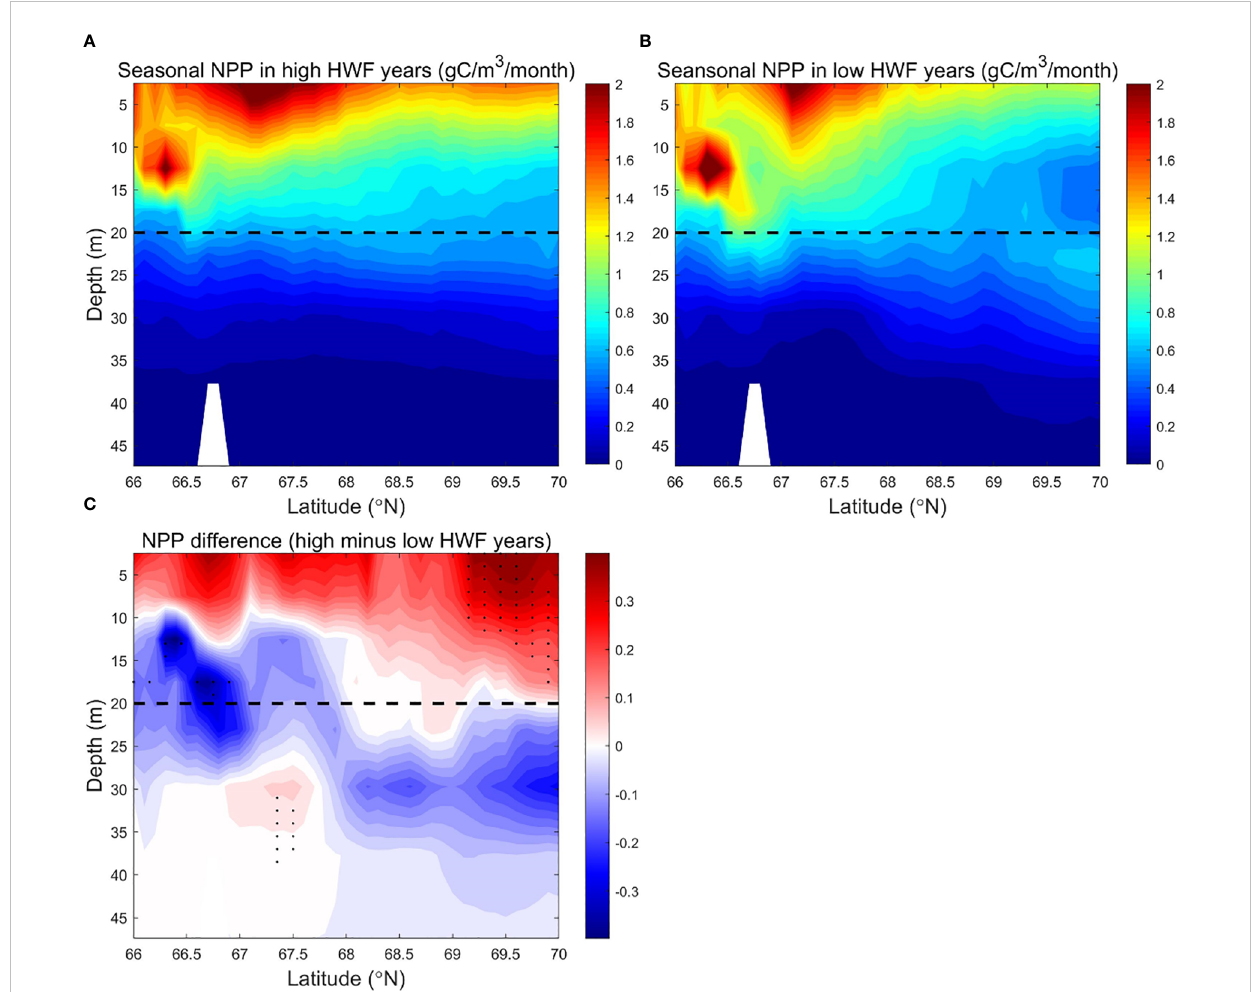
FIGURE 7 Modeled seasonally (June to September) averaged NPP (g C/m3/month) in the SC in the (A) high (1990, 1996, 2001, 2011, 2012) and (B) low (1992, 1995, 2002, 2004, 2007) HWF yeas, and (C) their differences (high minus low). The dashed lines denote 20 m depth. In Figure 7C, black dots denote where